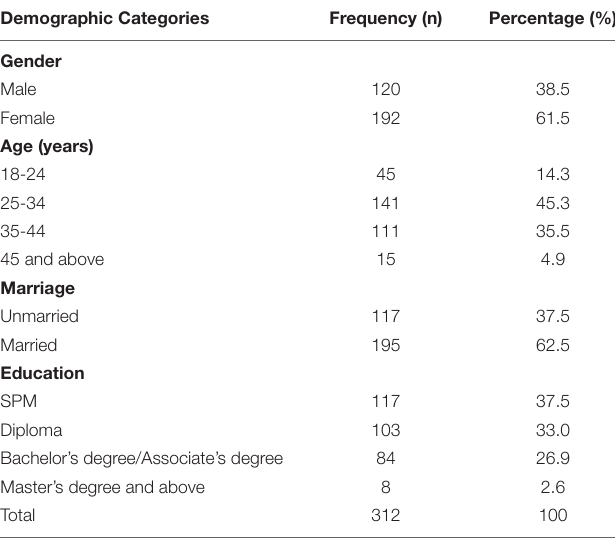
TABLE 1 | Profile of the